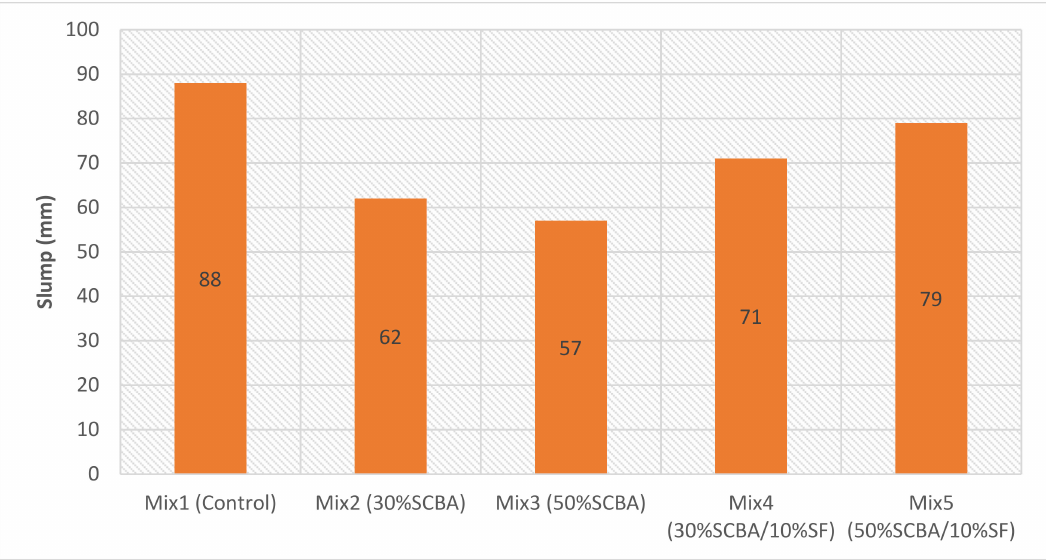
Figure 7. Workability obtained for each mix, in terms of